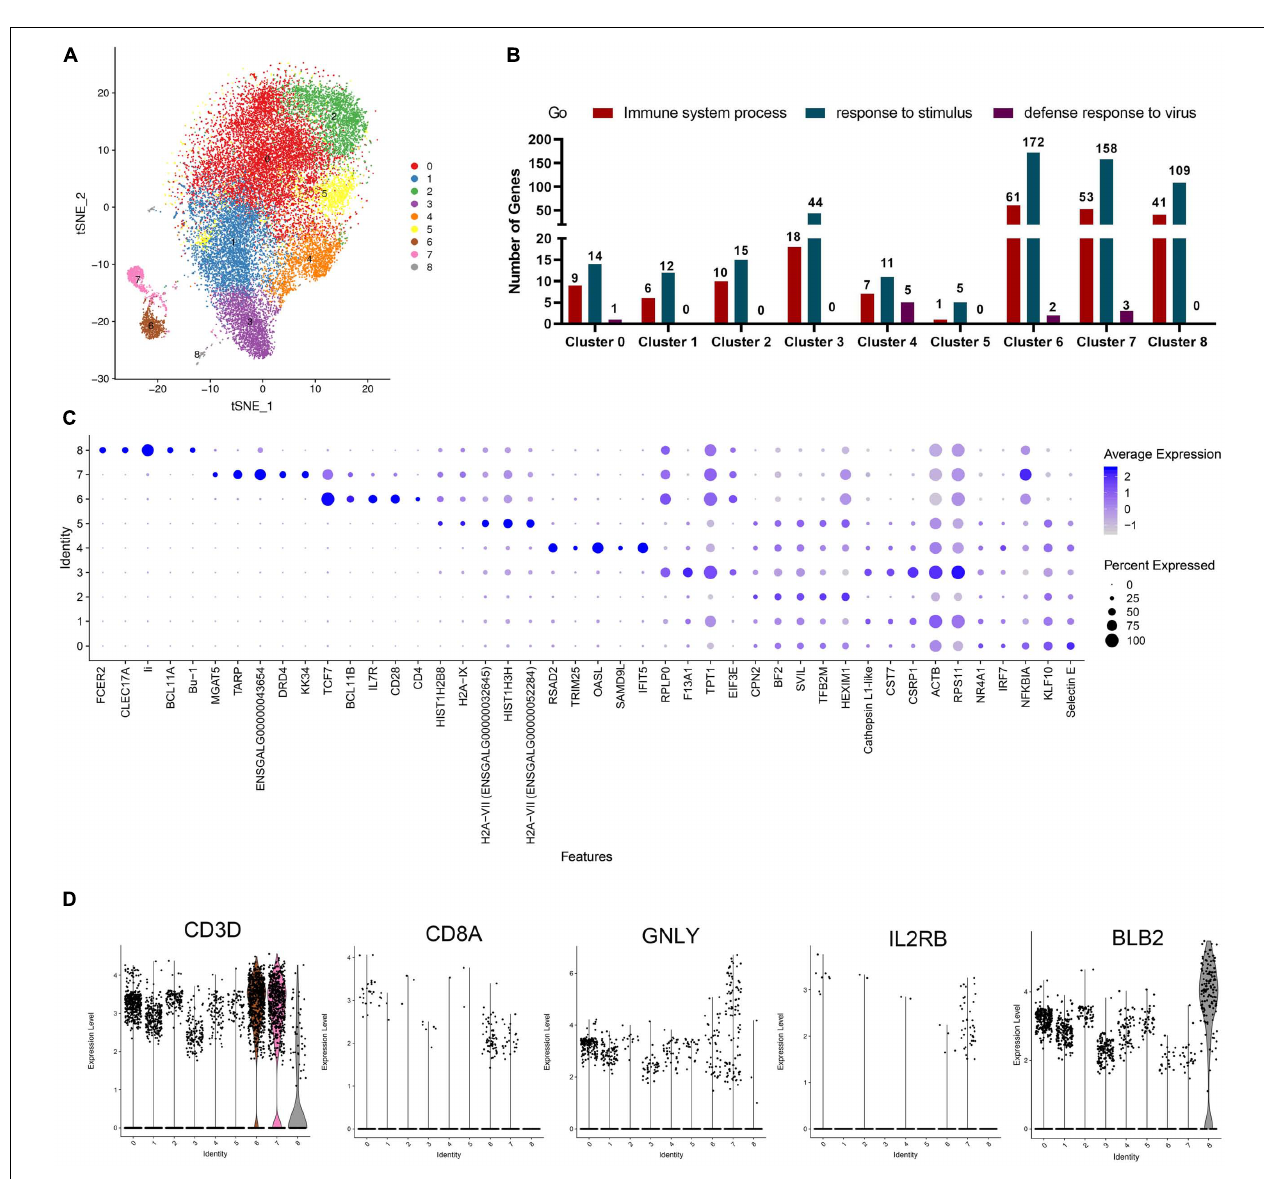
FIGURE 2 | Analysis of cell types of each cluster in chicken PBMCs. (A) t-Distributed Stochastic Neighbor Embedding (t-SNE) projection representing the eight clusters of cells identified in the chicken PBMCs (unified set of control and ALV-J infection samples). (B) The statistics of genes involved in the GO terms “immune system process,” “response to stimulus,” and “defense response to virus,” as analyzed in each cluster. (C) Top five DEGs (x-axis) identified in each cluster (y-axis). Dot size represents the proportion of cells in the cluster that express the gene; intensity indicates the mean expression level ( Z -score) in the cells, relative to those from other clusters. (D) Expression levels of the characteristic marker genes ( CD3D , CD8A , GNLY , IL2RB , and BLB2 ) in PBMCs